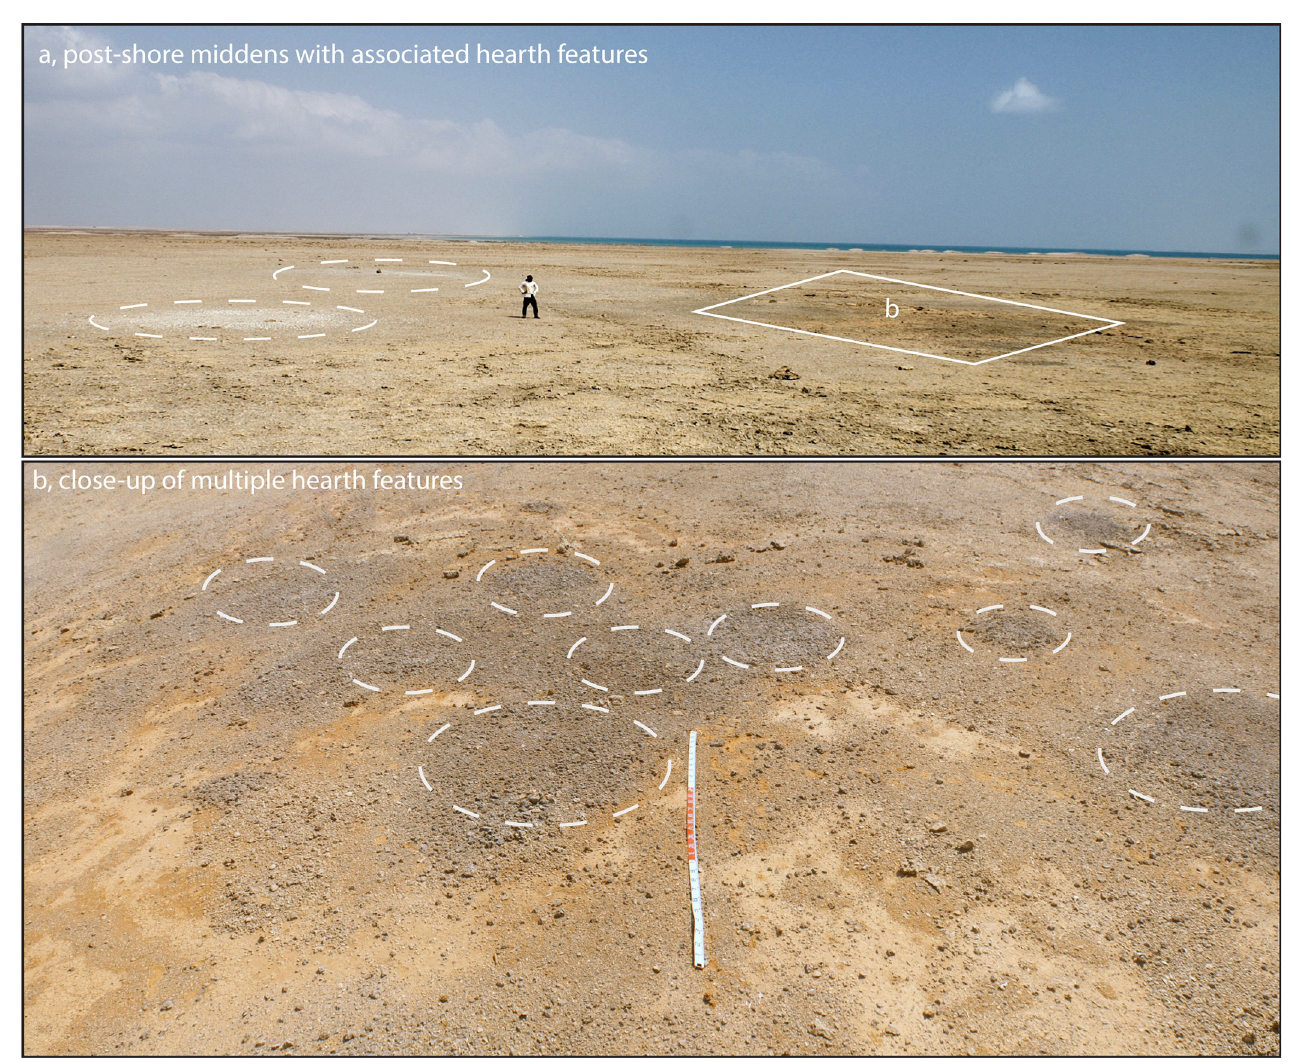
Fig 6. Post-shore scatters. (a) Shallow post-shore shell scatters found close to circular patterns of burnt material in the Janaba East cluster with shell mounds on the main shoreline visible in the distance; b: close up of multiple burnt areas–scale is 3 m. Photo by Niklas Hausmann, February